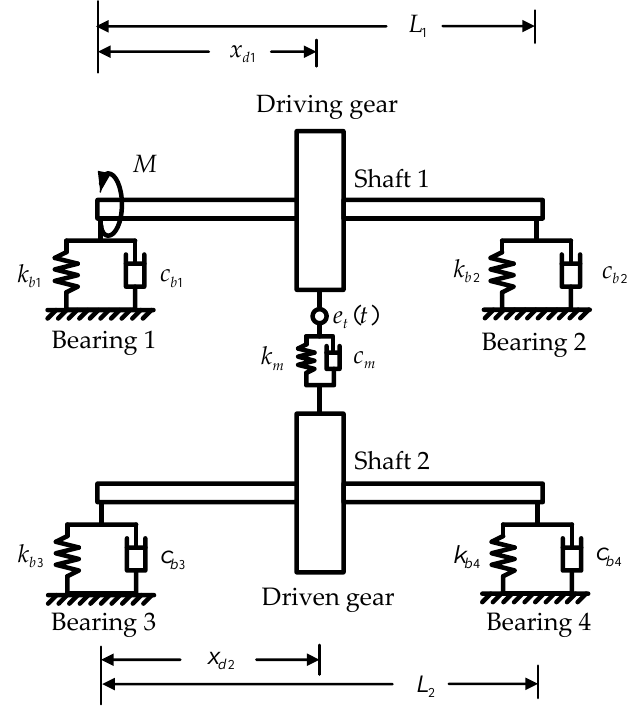
Figure 1. Configuration of the helical-geared rotor-bearing system.